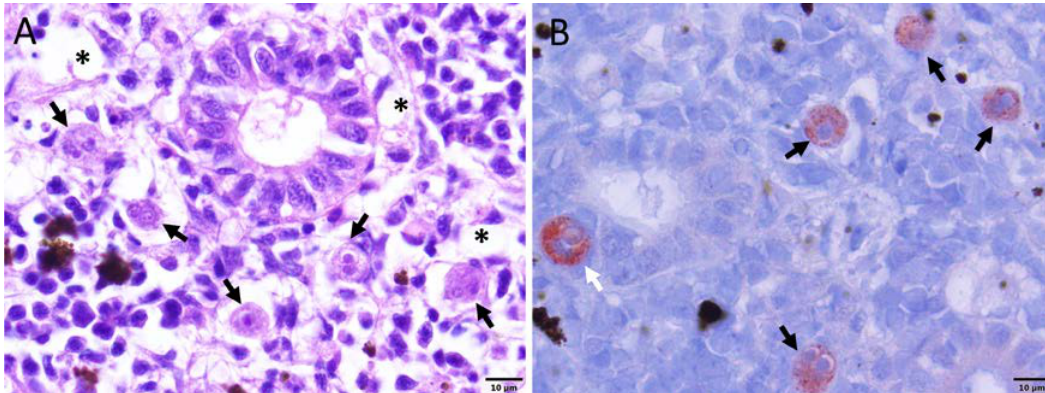
Figure 1. Brown trout exhibiting clinical signs of proliferative kidney disease. ( A ) Unexposed control brown trout having normal spleen (black arrow) and kidney (white arrow). ( B ) Exposed brown trout showing swollen spleen (black arrow), and swollen kidney (white arrow).